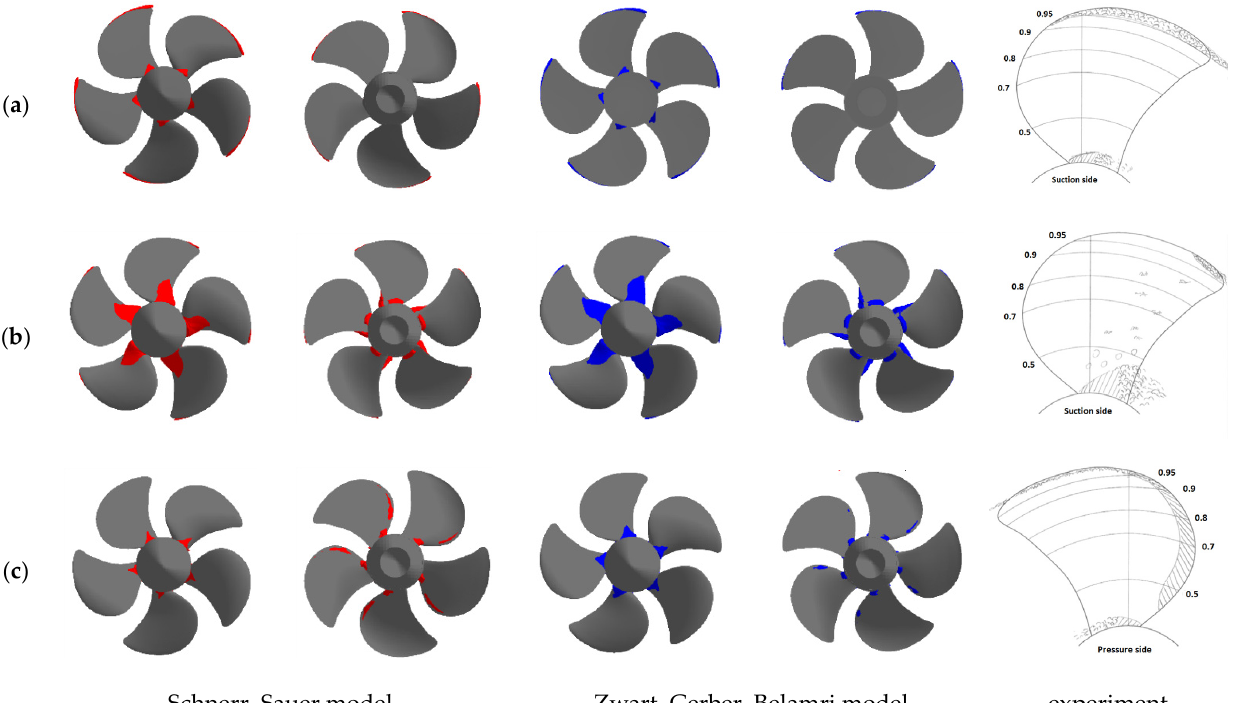
Figure 8. Volume fractions of cavitation vapor above 50%: ( a ) Test mode 1; ( b ) Test mode 2; ( c ) Test mode 3.